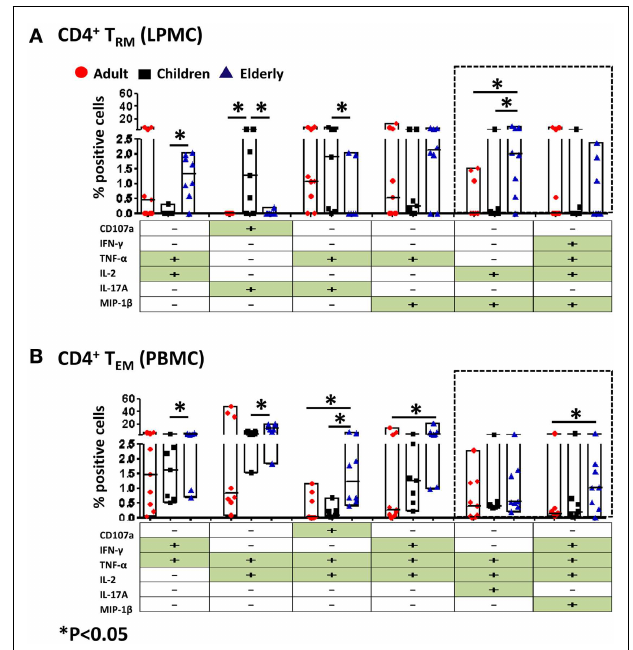
FIGURE 7 | Multifunctional gastric LPMC CD4 + T RM and PBMC CD4 + T EM responses to SEB stimulation in adults, children, and the elderly . Multifunctionality was determined by simultaneous detection of two or more functions performed by CD4 + T RM (LPMC) or CD4 + T EM (PBMC). Six functions were evaluated: production of five cytokines/chemokines (IFN- γ ,TNF- α , IL-2, IL-17A, MIP-1 β ) and expression of CD107a in response to SEB stimulation. (A) Scatter plot showing the six predominant function patterns in LPMC CD4 + T RM and (B) in PBMC CD4 + T EM cells from adults (red circles, n = 9), children (black squares, n = 7), and the elderly (blue triangles, n = 8). Multifunctionality was analyzed using the FCOM feature ofWinList. Significant differences between age groups were denoted by asterisks (* p < 0.05). Black dotted boxes indicate the same multiple cytokine-producing cells in LPMC and PBMC CD4 + T